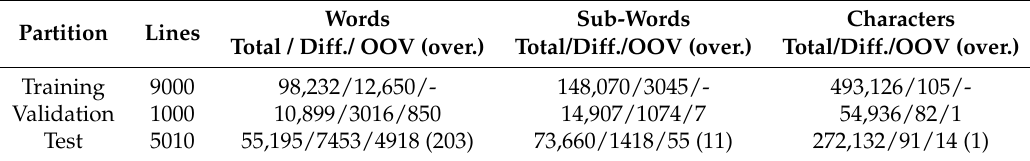
Table 1. Description of the partitions of the Rodrigo corpus used in this